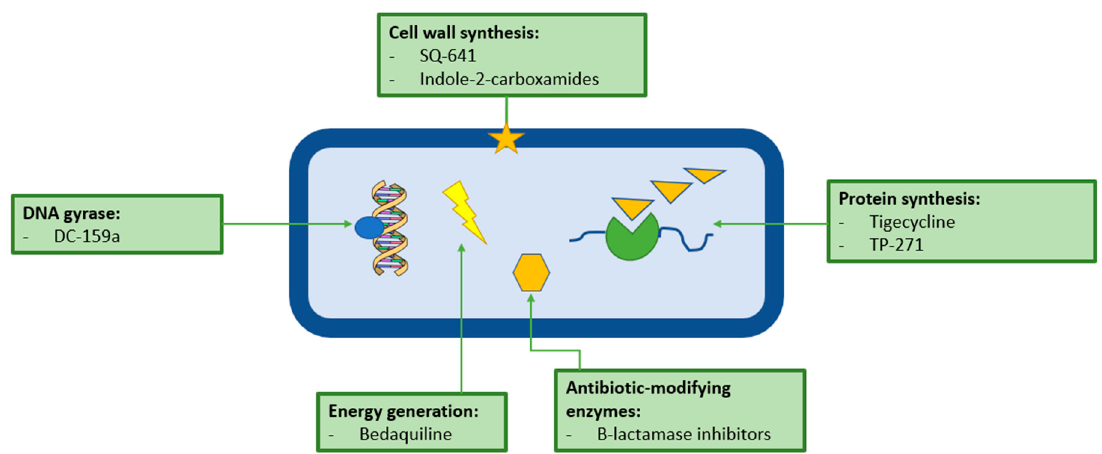
Figure 4. Graphical summary of the exploitable drug targets in Mycobacterium abscessus ( M. abs ). There are several potential target areas in M. abs including physiological, genomic, enzymatic and metabolic processes. Many of the drugs with potential to be used as part of M. abs treatment are old classes of antibiotics that have been repurposed, such as β -lactamase inhibitors, or have been discovered as part of the anti-tuberculous drug discovery pipelines, such as bedaquiline.